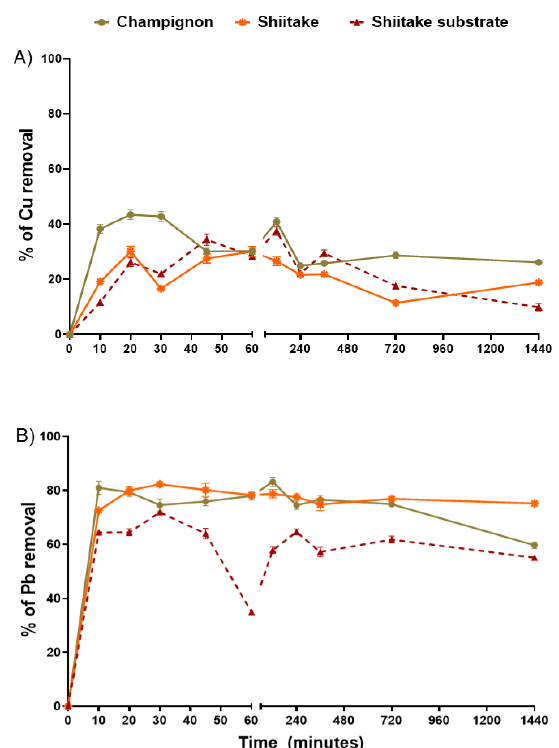
Figure 1. Copper (Cu) ( A ) and Lead (Pb) ( B ) removals. Both were assessed with Cu or Pb solution, 1000 mg/L − 1 , and 0.5 g of adsorbent, such as stalks of shiitake and champignon, and substrate of